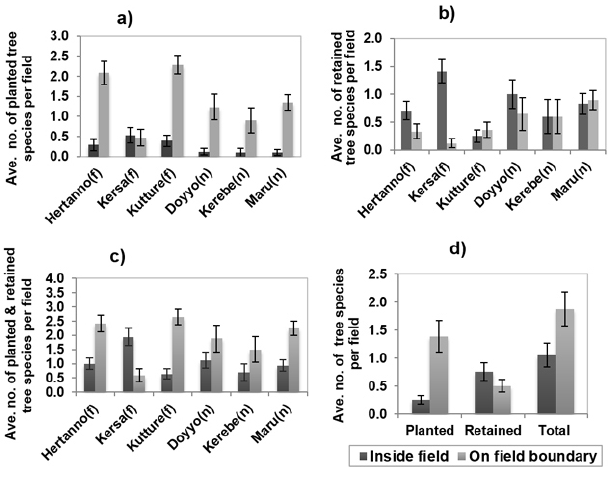
Fig. 3 . Average numbers of tree species, recorded inside and along boundaries of grazing lands for: (a) planted, (b) retained, (c) planted and retained pooled for individual villages, and (d) pooled data from all villages. The statistical interpretations of the patterns are found in the text. Error bars are standard error. The sample size is found in Table